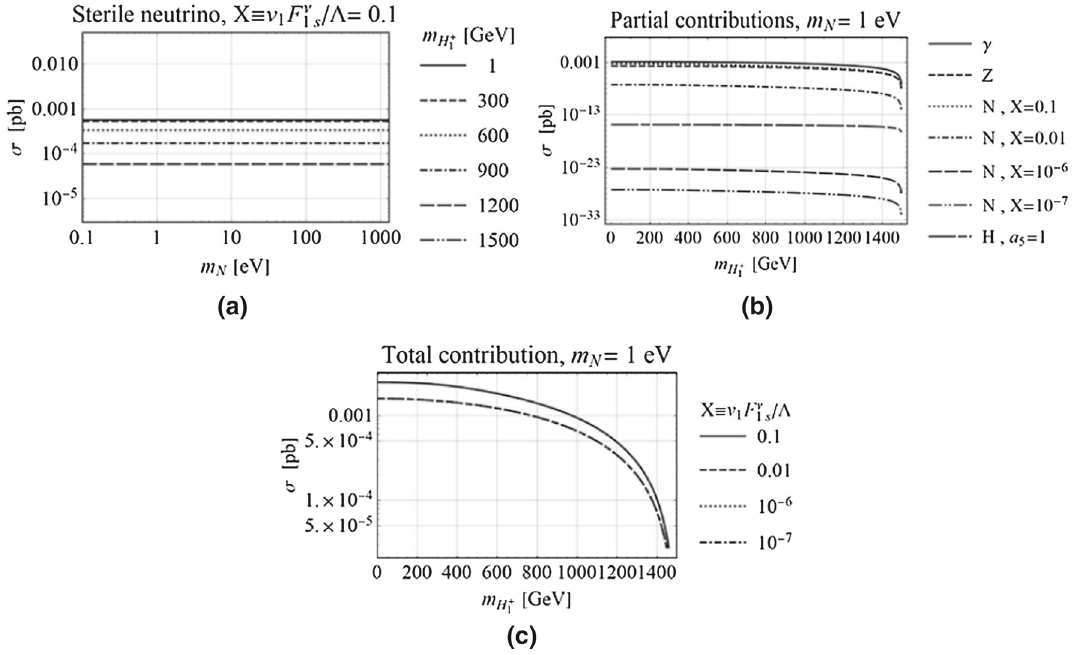
√ H − s = scalar. b The partial contribution to the cross section as a function of cross section with 1 1 the charged scalar mass. c The total cross section as a function of the charged scalar mass